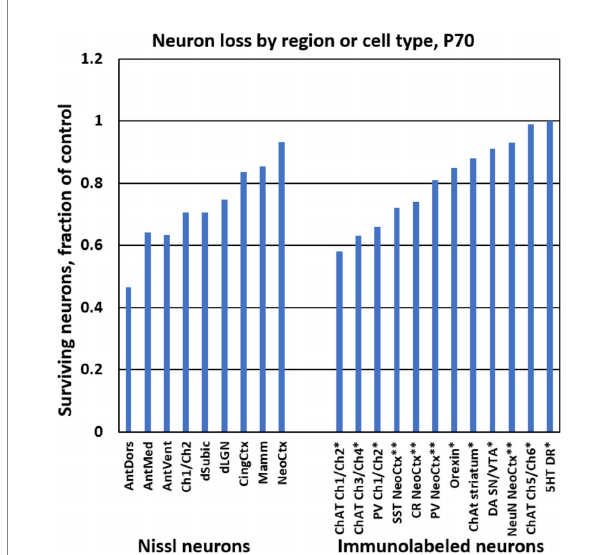
FIGURE 4 Graphs show the number of Nissl-stained apoptotic cells in each region, expressed as a percent of the total neuron number. The number of apoptotic cells was estimated in P7 brains at 8 h after the onset of ethanol treatment. In each region ethanol treatment caused a robust increase in the number of apoptotic cells compared to saline controls. However, the percent of total cells identified as apoptotic was only a fraction of the total cumulative neuron loss (see Figure 2), indicating that most neurons that died in response to ethanol have already been cleared and are no longer detectable by this